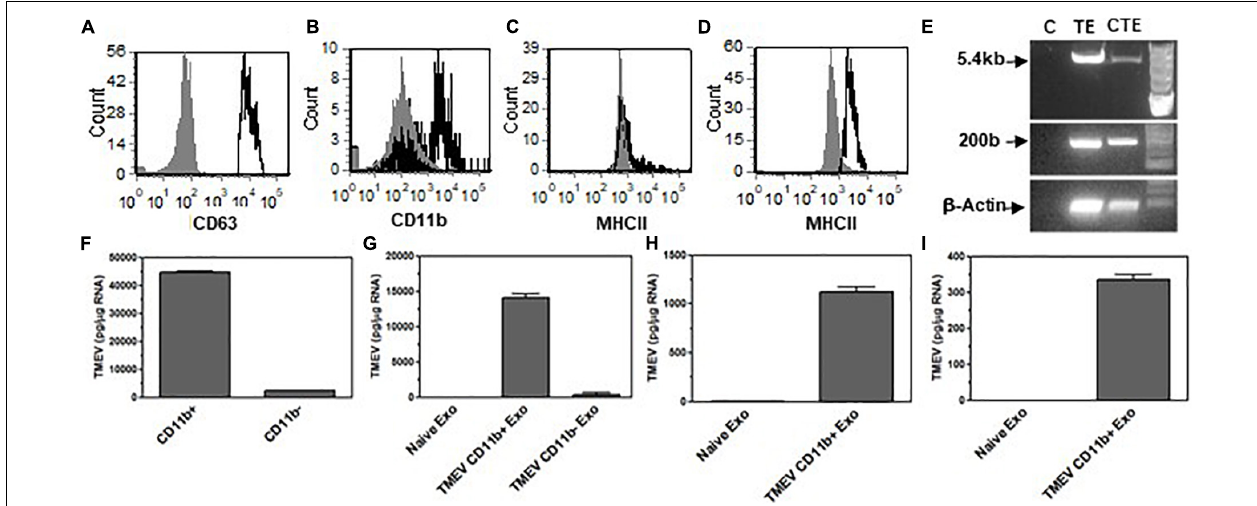
FIGURE 7 | Exosomes secreted by microglia during TMEV infection of mice contain viral RNA that can be transferred to bystander CNS cells. Exosomes were isolated from the brains of TMEV-infected mice at day 2 post-infection (three mice per group). The exosomes were labeled with fluorescently labeled antibodies for CD63, CD11b, and MHC class II. The exosomes were analyzed by flow cytometry for CD63 (A) and CD11b (B) and MHC class II in CD11b - exosomes (C) and CD11b + exosomes (D) with the specific antibodies in black lines and isotype control antibodies in gray. (E) Mice were infected or mock infected with TMEV. At 2 days post-infection, exosomes were isolated from the brains and sorted for CD11b + exosomes. RNA was isolated from the CD11b + exosomes from mock infected mice (C) and TMEV-infected mice (TE). RNA was converted to cDNA, and used in PCR analysis with primers for TMEV long (5.4 kbp) or short (200 bp) products or with primers for β -actin. Microglia were incubated with CD11b + exosomes isolated from the brains of TMEV-infected mice (lane CTE). The cells were lysed 24 h later and RNA isolated, converted to cDNA and used in PCR analysis. (F) At day 2 post-infection, exosomes were isolated from TMEV-infected mice brains and sorted into CD11b + and CD11b - exosomes. The exosomes were analyzed for TMEV using real time PCR. (G–I) The exosomes isolated from TMEV-infected mice brains were sorted into CD11b + and CD11b - exosomes and placed on unstimulated cultures of microglia, astrocytes, and neurons. After 24 h, the cells were lysed, RNA isolated, converted to cDNA and analyzed by real time PCR for TMEV in microglia (G) , astrocytes (H) , and neurons (I) . These are representative graphs from one experiment of four independent repeated experiments.